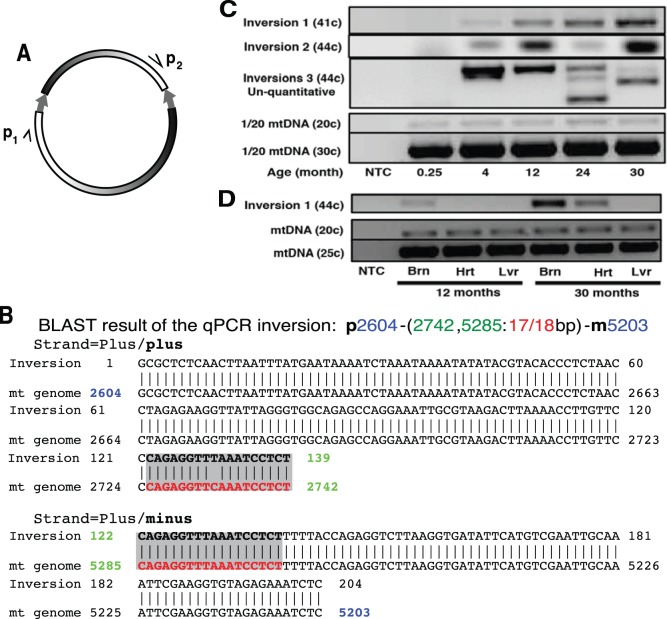
IRs-mediated inversions accumulate with age in mouse brain and heart.(A) Primer pair p1 and p2 amplifying inversion will not generate a PCR product on a normal mtDNA template. (B) Example of an inversion (inversion #1) obtained by sequencing a PCR product. The IR sequence that mediated the inversion is shaded gray. The plus strand of the inversion matches a sequence on the plus strand and a sequence on the minus strand of the mitochondrial (mt) genome. (C) Inversions amplified from the mouse brain. Different inversions were amplified by different primer pairs (Materials and Methods 5). The number of PCR cycles is indicated in parentheses. (D) Inversions accumulate in brain and heart. NTC, no template control.